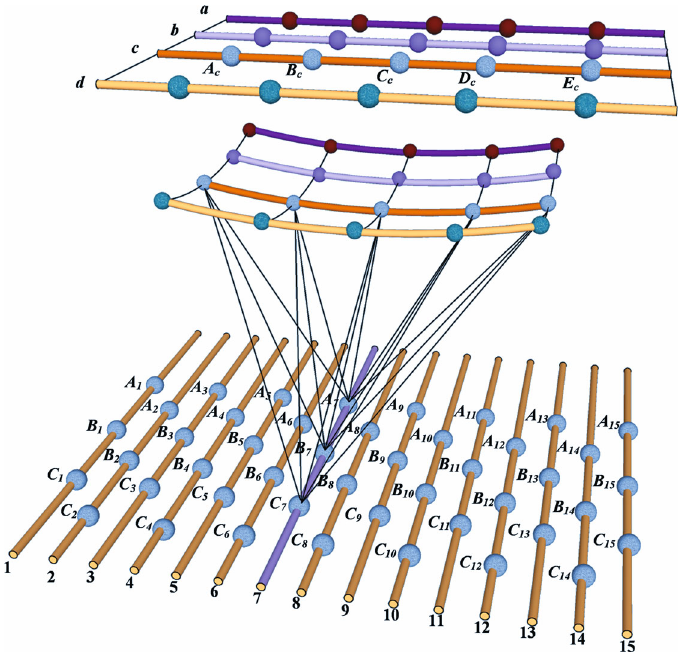
Figure 1: Output matrix of neural